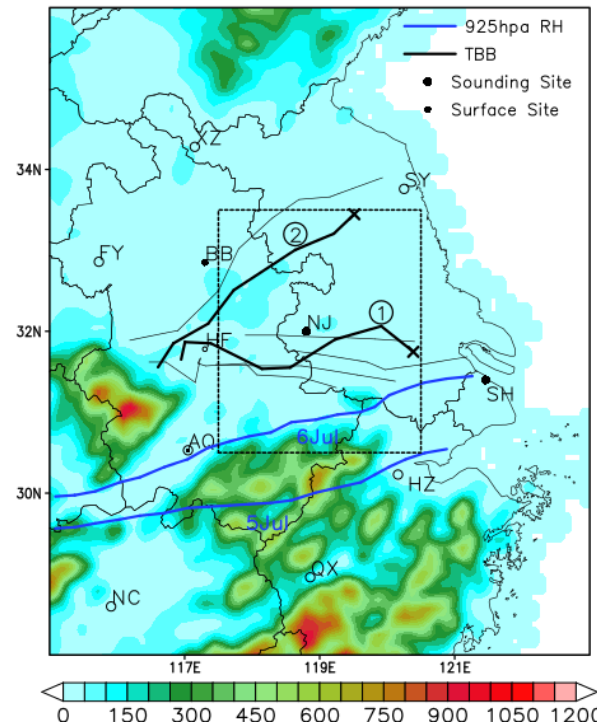
Figure 2. Topography (shaded, units: m), the largest gradients of relative humidity at 925 hPa (blue thick solid line) on 5 and 6 July. The track of the coldest cloud top temperature (black thick line) when the two main MCSs cross the studied area (dotted box), in which the dashed black thick lines show the track of the early stage when the area of the convective systems is less than 1° × 1°. The surface and sounding sites of the CMA (Chinese Meteorological Administration) which have experienced the 2.5-day rainstorm over the studied region are plotted with solid circles.